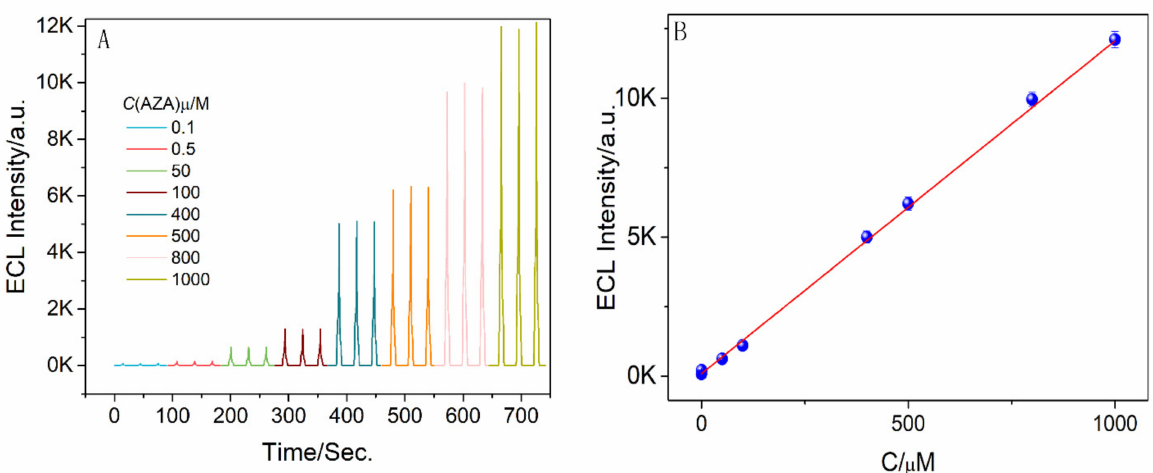
Figure 6. Detection AZA. ( A ) ECL–time profiles and ( B ) Calibration curve obtained for AZA detection from 0.1 to 1000 µ M. Detection was employed in 0.1 M PBS (pH 8.5) in the presence of 0.5 mM Ru(bpy) 32+ ; PMT = 900 V.